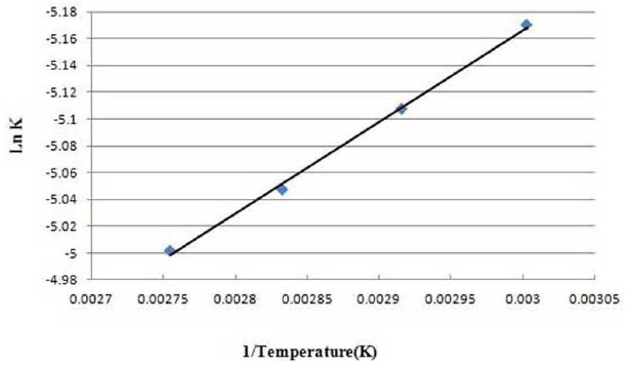
FIGURE 4 - Arrhenius plot of HCTZ-lactose liquid mixture at